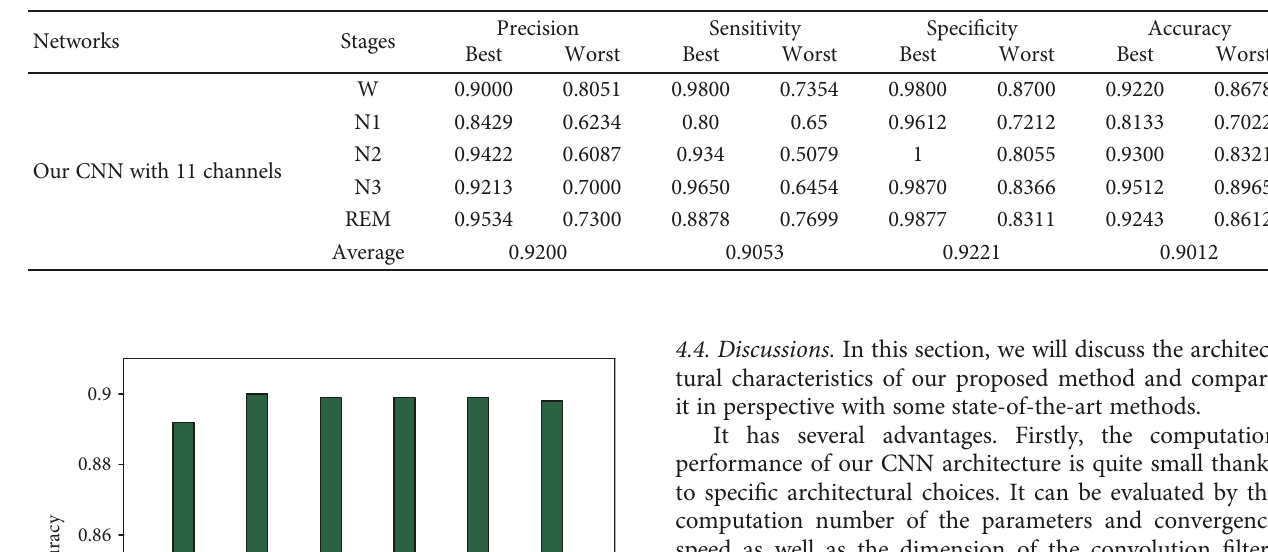
Table 5: Evaluation results of CNN with 11 channels.